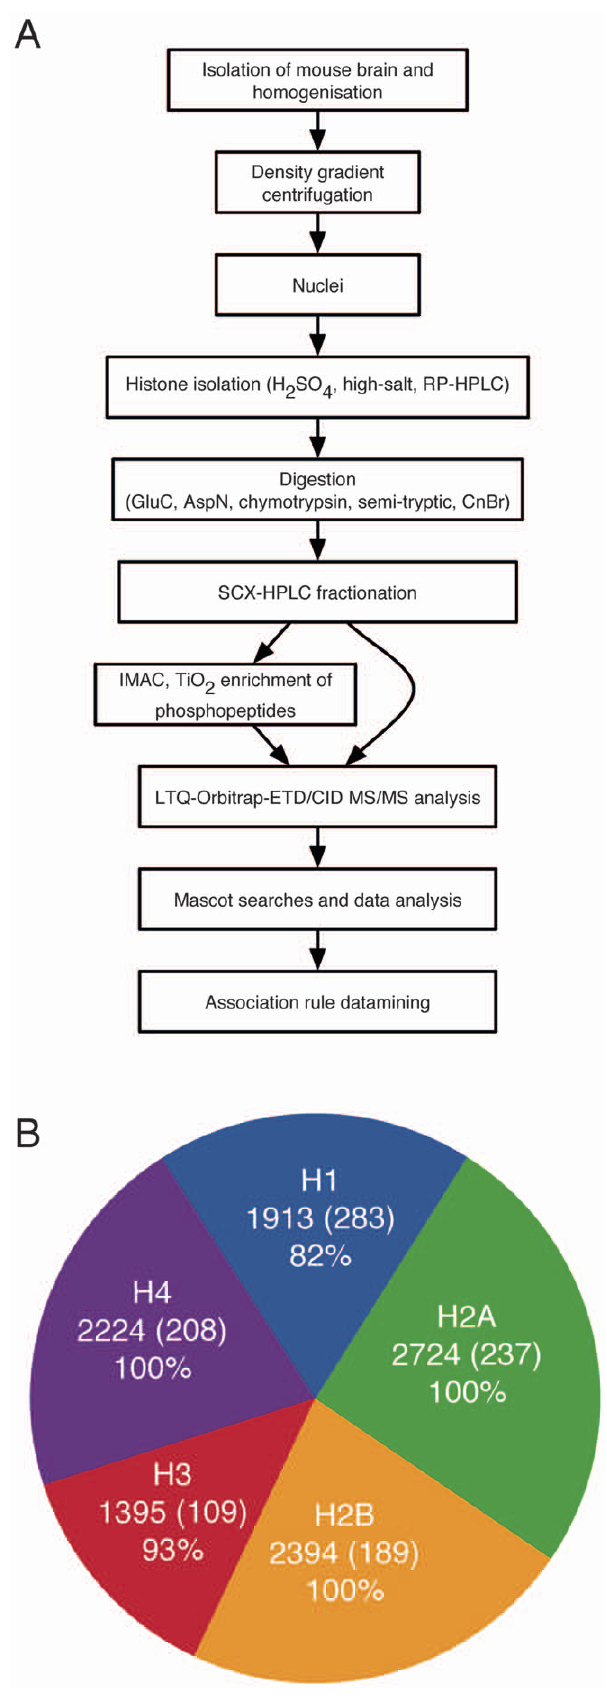
Figure 1. Proportion of detected histone peptides in the adult mouse brain. A ) Workflow for the isolation and analysis of long histone peptides from the mouse brain. B ) Number of peptides identified for each histone subtype, in brackets the number of unique peptides identified and typical sequence coverage